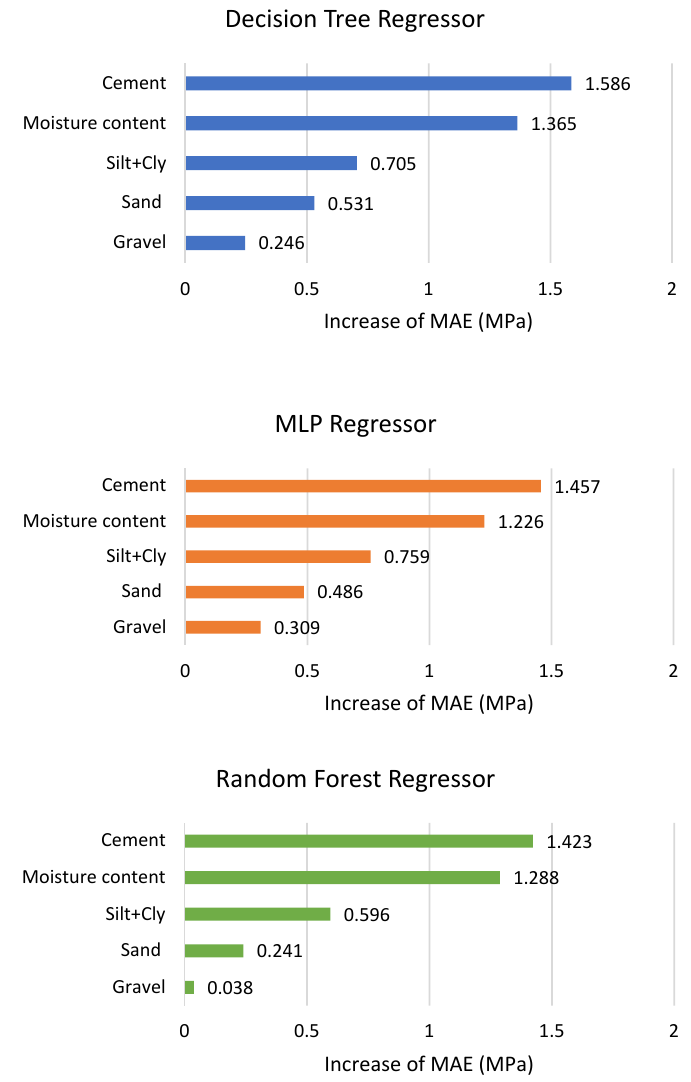
Figure 6. Feature importance plots from drop-out loss based on DTR, MLP regressor, and RFR (silt and clay jointly considered).